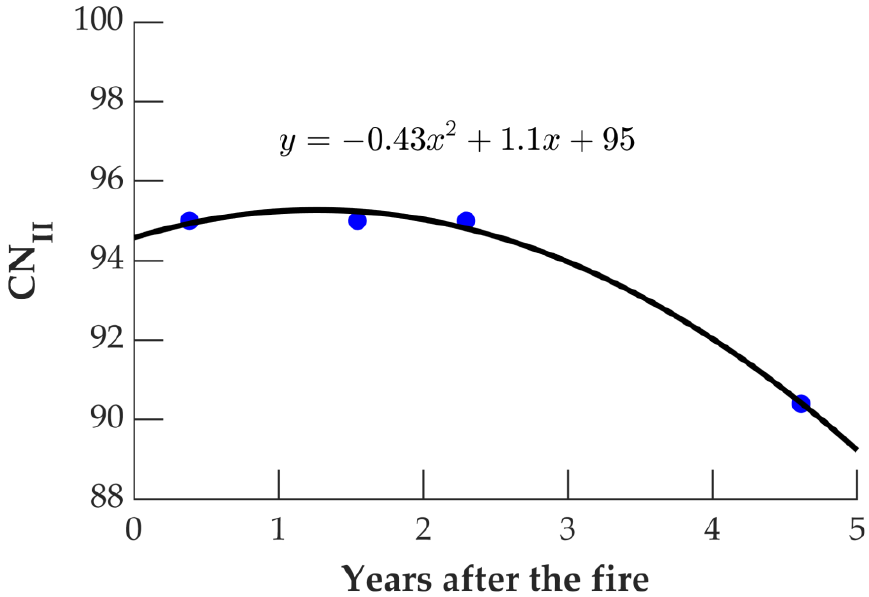
Figure 9. Trend of Curve Number CN II , as revealed through analysis at the flood event scale; HEC-HMS is used.